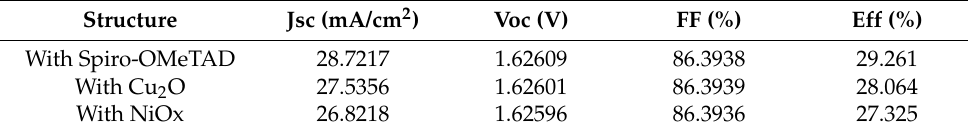
Table 4. Performance parameters of the p-i-n perovskite solar cell structures for three HTMs. Structure Jsc (mA/cm 2 ) Voc (V) FF (%) Eff (%) With Spiro-OMeTAD 28.7217 1.62609 86.3938 29.261 With Cu 2 O 27.5356 1.62601 86.3939 28.064 With NiOx 26.8218 1.62596 86.3936